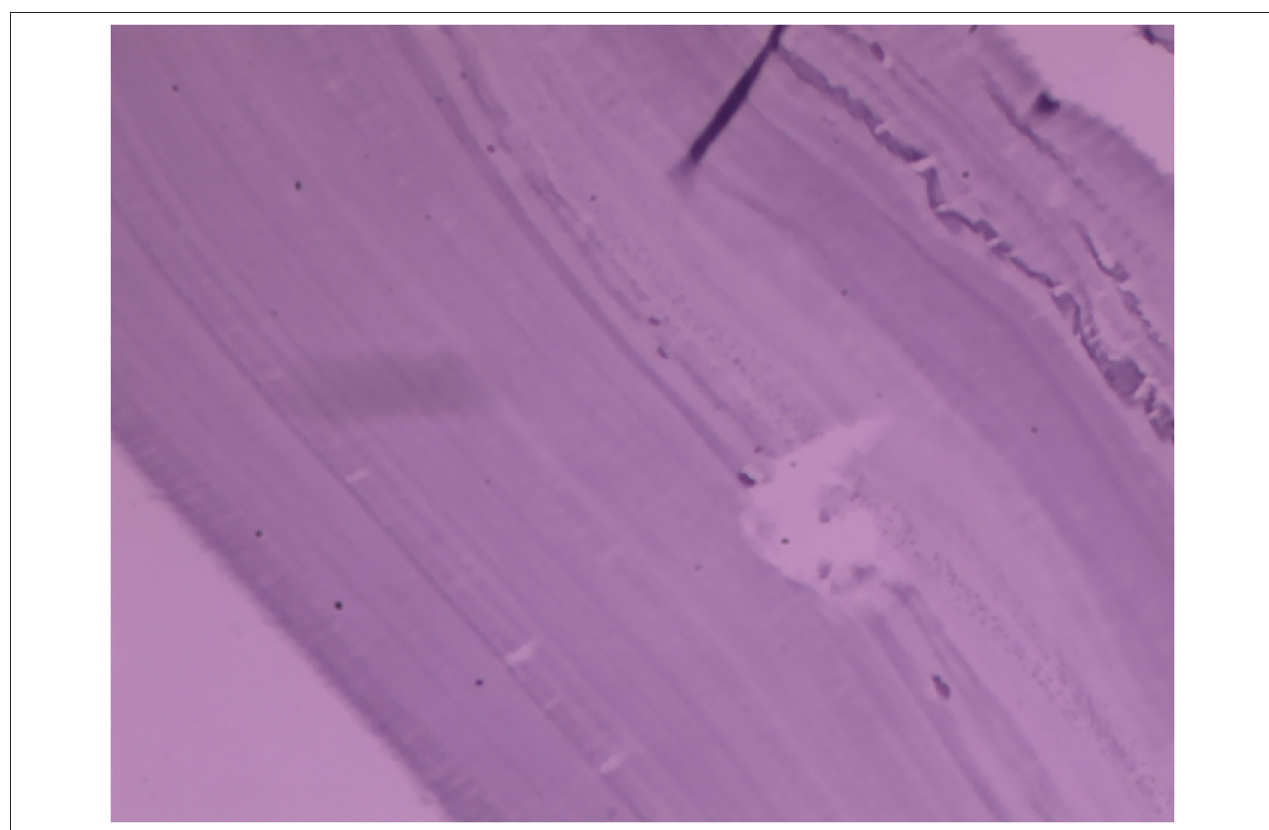
FIGURE 3 | In the histopathological examination, after Hematoxylin and Eosin (H&E) staining of the cyst, endocyst’s germinal layer could be